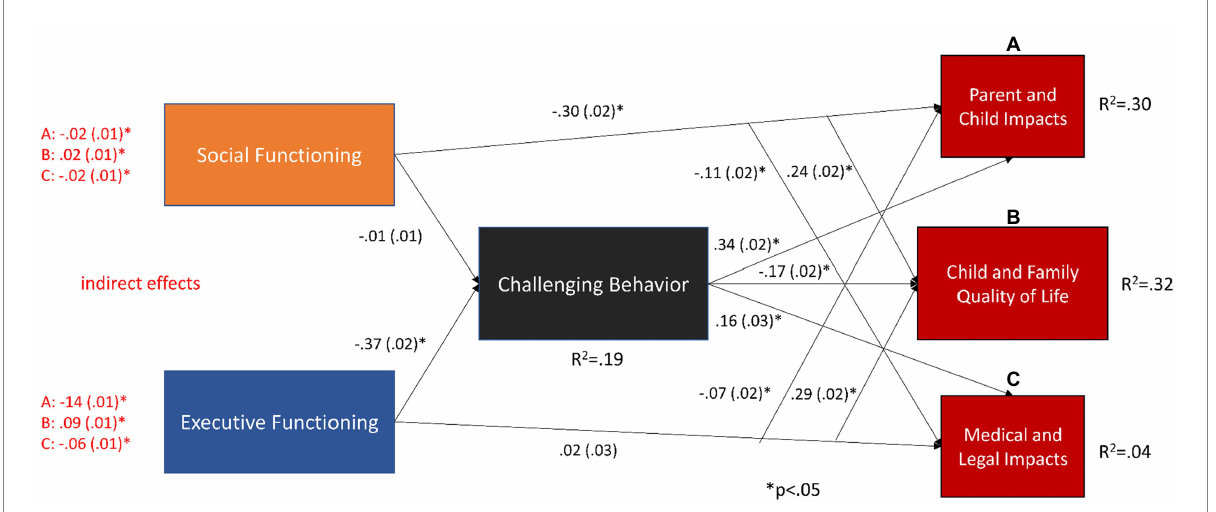
FIGURE 3 Mediational model estimating direct effects of executive and social functioning on quality of life and functional impacts as well as indirect effects via challenging behavior. The model is just identified. Branching arrows represent direct effects from social and executive functioning to child and family quality of life and functional impact measures. Red font designates indirect effects from social or executive functioning to parent and child impacts (A) , child and family quality of life (B) , or medical and legal impacts (C) . Residual correlations were as follows: social functioning with executive functioning r = 0.38; CFQL-2 with Parent and Child Impacts r = − 0.26; CFQL-2 with Medical and Legal Impacts r = − 0.08; Parent and Child Impacts with Medical and Legal Impacts r =